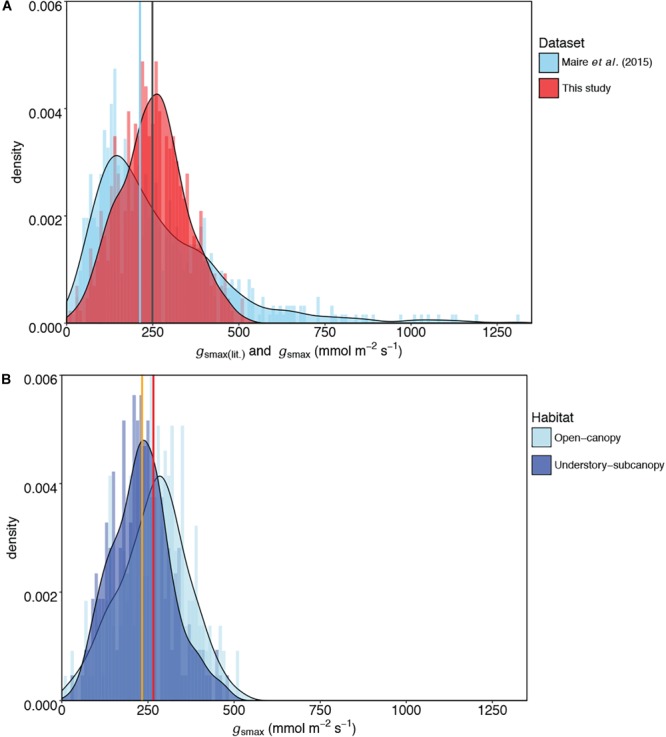
Comparisons of kernel density plots of maximum stomatal conductance (gsmax) for (A) this study and published literature [gsmax(lit)] (Maire et al., 2015), and (B) the open-canopy habitat and understory-subcanopy habitat. In (A) the central tendencies of each dataset are indicated by vertical lines in blue (median) for Maire et al. (2015) and gray (mean) for this study; in (B) the vertical orange line indicates the mean gsmax of the understory-subcanopy habitat and the red line the mean gsmax of the open-canopy. For visual readability, the x-axis in (A) was limited to 1,350 mmol m-2 s-1 instead of the maximum value of 2,272 mmol m-2 s-1 in Maire et al. (2015) dataset (see Table 5).